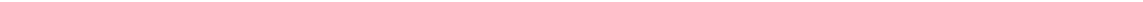
Fig. 1 The Rac activator STEF localises at the nuclear envelope. a Representative high-resolution confocal immuno fl uorescence images of parental U2OS cells and two U2OS CRISPR clones stained for DNA (DAPI) and STEF. b Fluorescence intensity pro fi les of DAPI and STEF signals across the nuclei of U2OS parental cells. Position of line scan indicated by the dashed white line in a . c Immuno fl uorescence images of endogenous STEF expression in mouse embryonic fi broblasts (MEFs) (top), primate fi broblast-like COS-7 cells (middle) and human lung adenocarcinoma A549 cells (bottom). d Immuno fl uorescence images of STEF expression in U2OS cells transfected with pcDNA3-FL-STEF-FLAG (left), pRETROXT-WT STEF-HALO (middle) or pcDNA3- Δ NSTEF-HA expressing a truncated STEF mutant (right). e Schematic representation of the domain structure of full-length STEF and a range of deletion mutant constructs of STEF. f Representative confocal images of U2OS cells transfected with a range of deletion mutant constructs of STEF (all in the pcDNA3 vector, with a C-terminal HA tag), stained for DNA (Hoechst) and HA. g U2OS cells were fractionated into cytoplasmic (Cyto), perinuclear- enriched (P.E.) and core-nuclear (Nuc) extracts using a successive lysis protocol. Lysates from each fraction were prepared containing equal total protein, and probed for expression levels of STEF alongside Tubulin (as a marker of the cytoplasmic fraction), Lamin B1 (LMNB1, as a marker of the core-nuclear fraction) and Nesprin-2G (as a marker of the perinuclear-enriched fraction). h Representative confocal images of parental U2OS cells permeabilised either with triton (top panels) or digitonin (bottom panels) and stained for STEF, DNA (Hoechst) and Lamin A/C. Scale bars throughout = 10 µ m, except in (h)